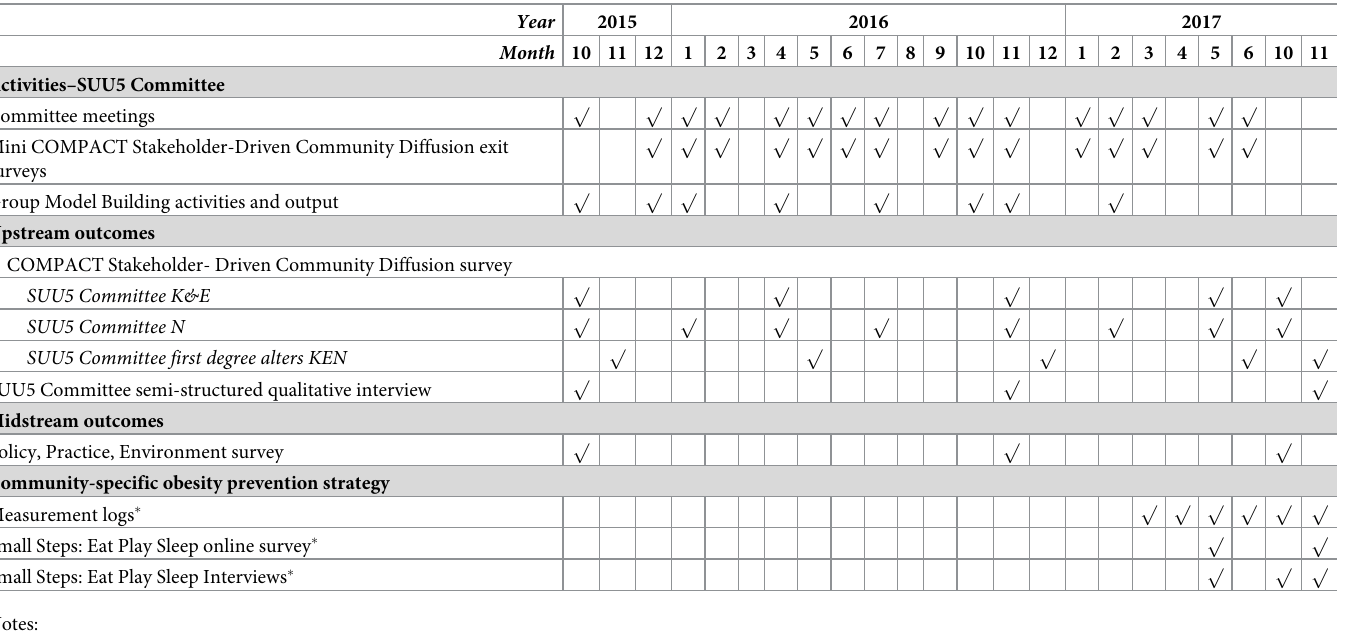
Table 2. Shape Up Under 5 data collection